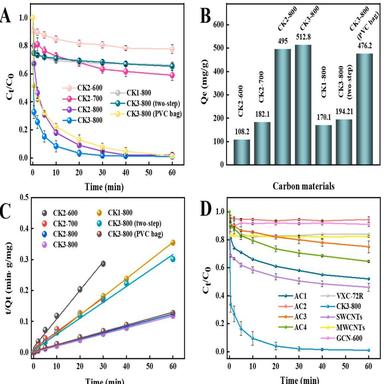
The adsorption capability comparison of various carbon materials (A–C), CK3–800, and commercially available activated carbons (D). Reaction conditions: TC = 50 mg L− 1 , adsorbents = 0.1 g L− 1 at 25 ℃.